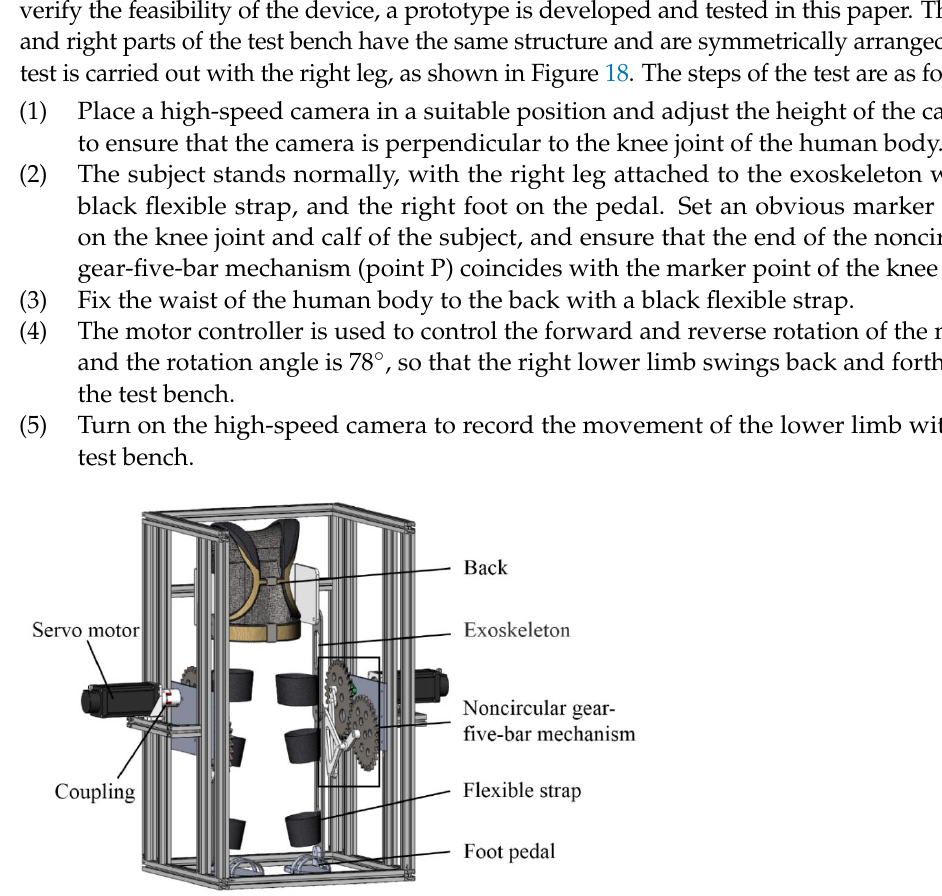
Figure 17. 3D model of the exoskeleton knee joint rehabilitation device.